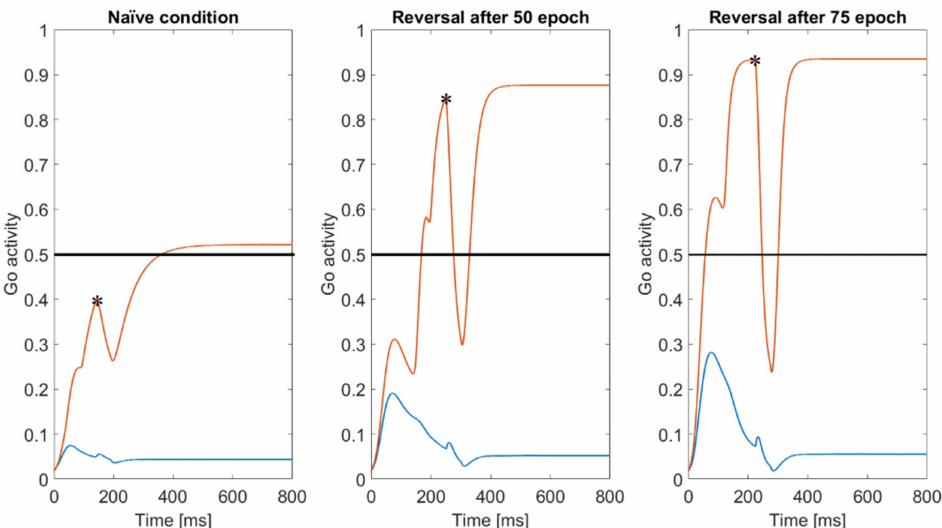
Figure 5. Temporal pattern of the activities of the two Go neurons, in response to a punishment. The red line represents the winner Go neuron (i.e., the one belonging to the selected action) while the blue line represents the activity of the Go neuron in the losing channel. The black horizontal thick line is the threshold for the post-synaptic neuron in the Hebb rule (equal to 0.5). The left panel represents the response in the naïve network (before any training) when the activity of the winner Go neuron settles close to the threshold. Hence, a small punishment is sufficient to achieve a synapse depotentiation. The other panels refer to the network at the beginning of the reversal phase, after 50 epochs of previous training (middle) and after 75 epochs of previous training (right), when an action previously reinforced is now punished. The winner Go neuron, as a consequence of previous learning, settles at a higher value: hence, a stronger punishment is required to move the activity well below the threshold, to allow the depotentiation of a previously learned habit. Finally, the asterisks represent the activity of the winner Go neuron immediately before the punishment, used to compute a value for the expected reward (see Equation (1)